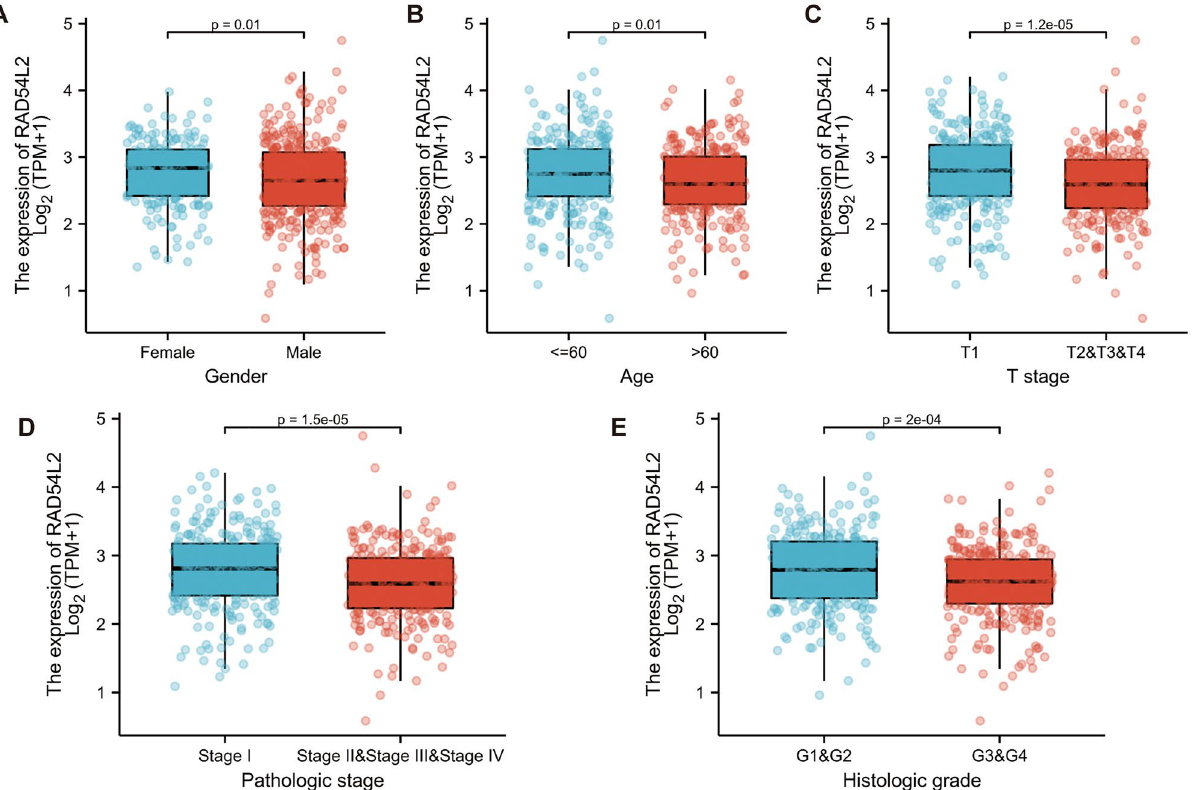
Figure 5. Association of Rad54l2 Expression and Clinicopathological Characteristics in RCC Patients. The association of Rad54l2 Expression with ( A ) Gender, ( B ) Age, ( C ) T stage, ( D ) Pathologic stage, ( E ) Histologic grade was